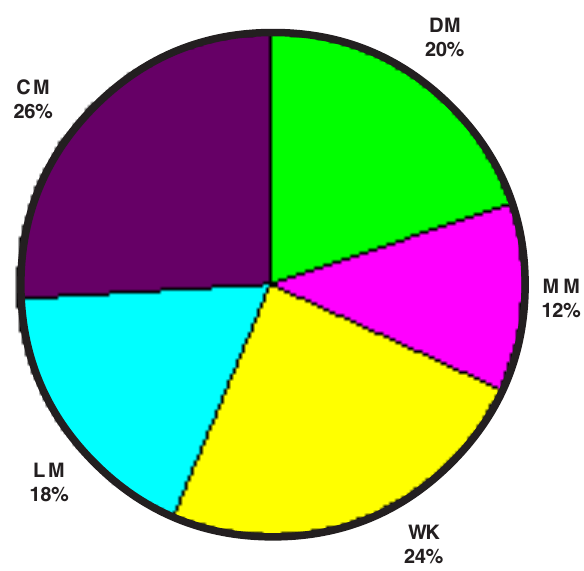
Figure 1. Percentage of Colletotrichum isolates obtained from five local markets. DM - Donggongon market; MM - Menggatal market; WK - Wong Kwok market; LM - Lido market; CM - Central market